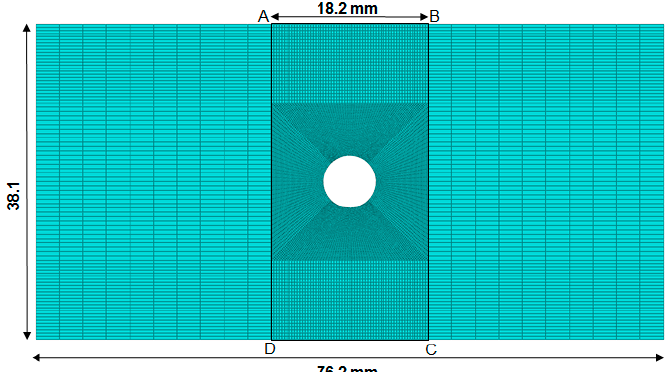
Figure 8. Mesh used for the notched tensile test specimen analyses.